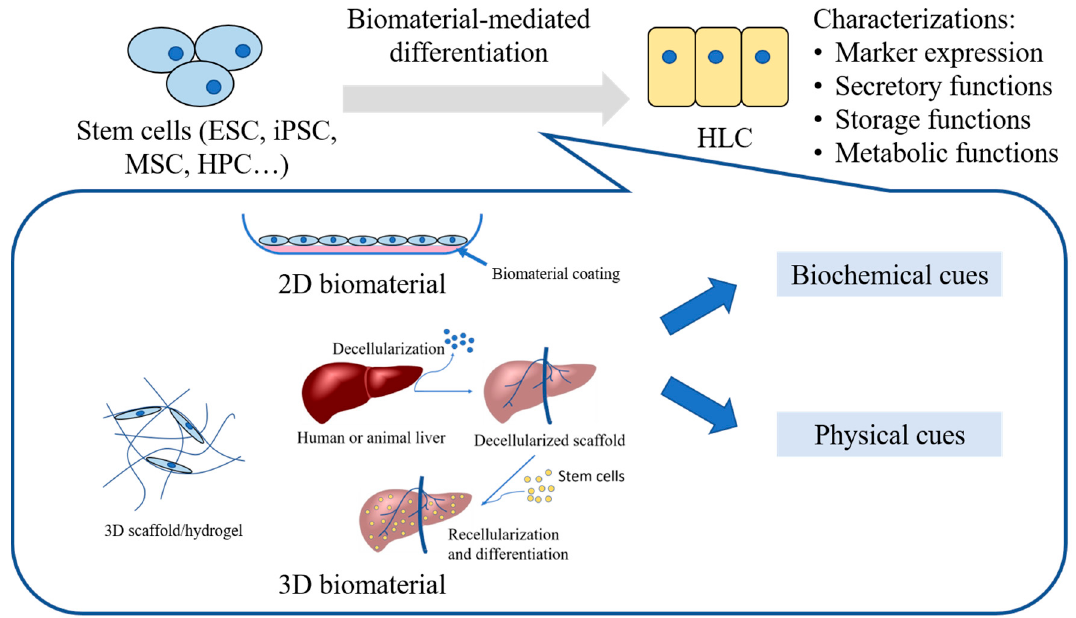
Figure 1. Schematic diagram of 2D and 3D biomaterial-mediated hepatic differentiation of stem cells.